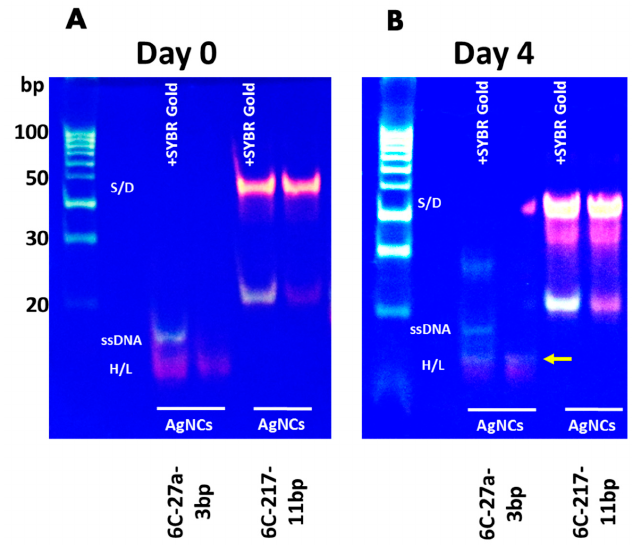
Figure 5. Native gel electrophoresis of ( A ) DNA 6C-27a-3bp / AgNCs and ( B ) DNA 6C-217-11bp / AgNCs performed after 1 h on day 0 and after 4 days post-AgNCs synthesis. Before running the gel, samples were prepared with or without SYBR Gold dye. The DNA bands were visualized either with SYBR Gold (SG) and / or native AgNCs fluorescence. Yellow emission of DNA 6C-27a-3bp / AgNCs on day-4 is indicated with arrow. The abbreviations cH / L- compact hairpin-loop or SD: self-dimer DNA or H / L: hairpin-loop describes the predicted DNA structures. DNA Ladder on the left shows 100bp size